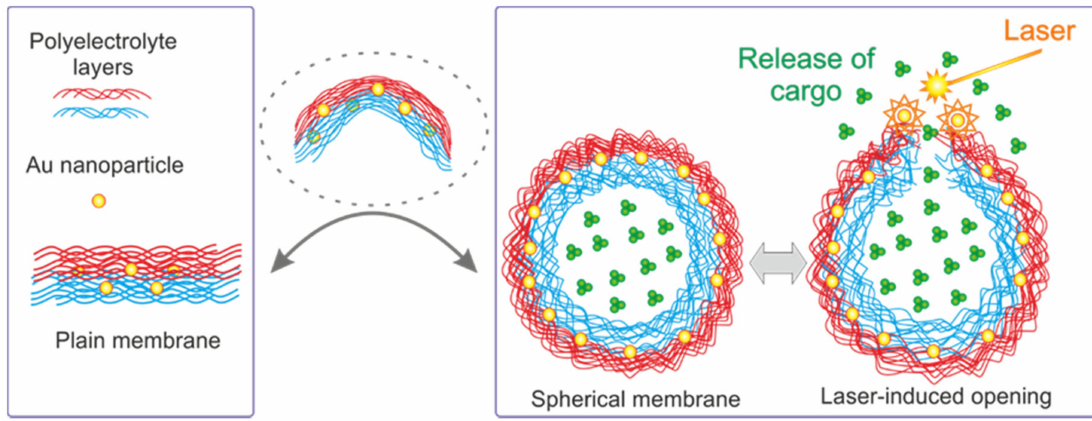
Figure 1. Schematic of a transition from flat membranes (real membranes depicted in the left-hand rectangle) to fully suspended membranes of